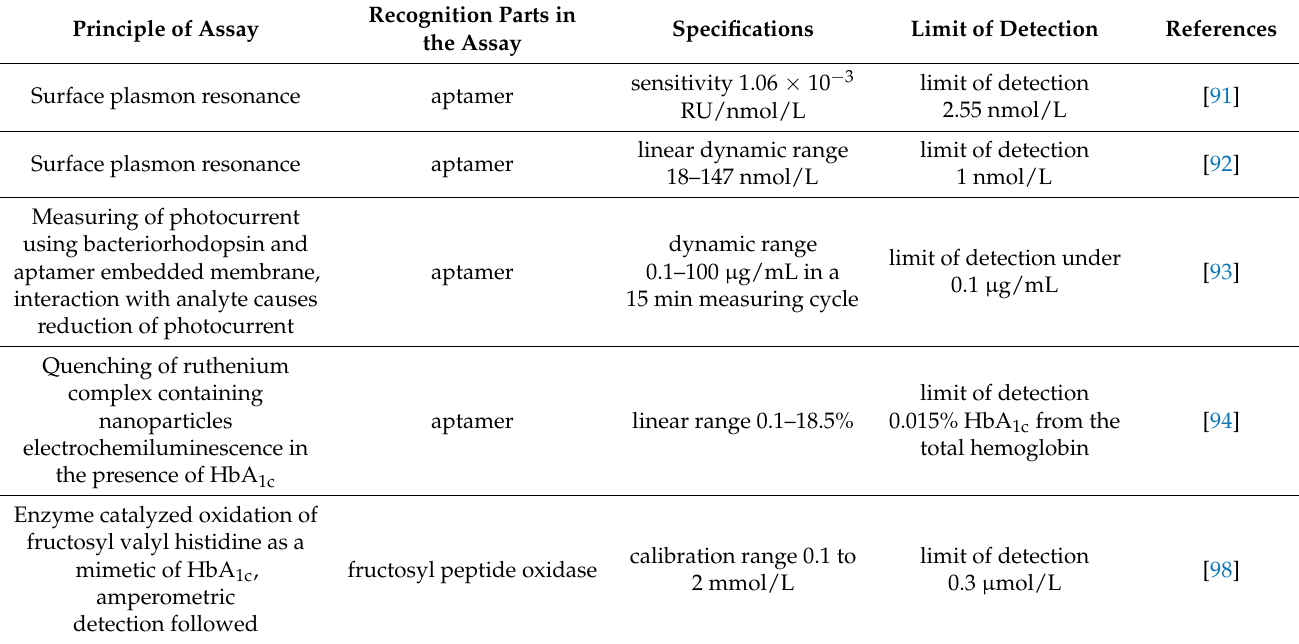
Table 2. Biosensors and bioassays for HbA 1c